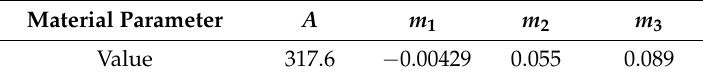
Table 3. Determined material-dependent parameters of the Hensel–Spittel flow curve approach for EN AW-6082.